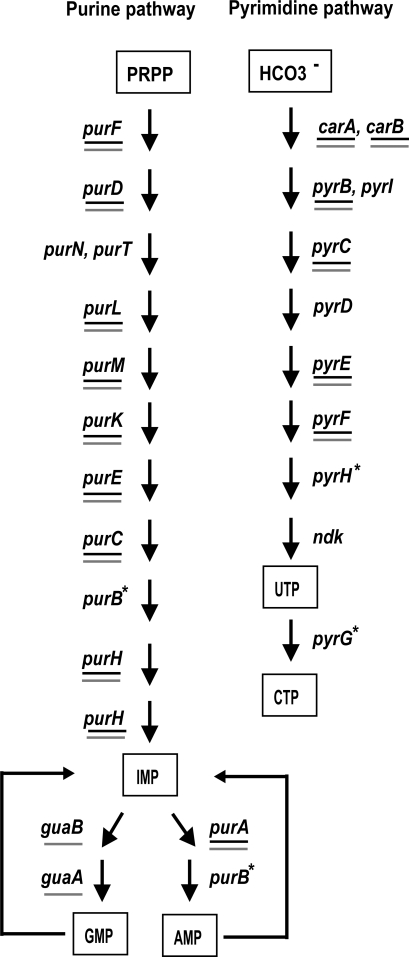
Genes Required for the Growth of E. coli in Human Serum Identified by MGK and MTT AssayPurine and pyrimidine nucleotide biosynthesis pathways in E. coli are outlined. Genes that were identified to be essential for the growth of E. coli in human serum by the MGK approach are underlined in black and those identified by the MTT assay are underlined in grey. Essential genes, whose deletions are absent from the defined library of E. coli mutants, are marked by an asterisk. Genes whose deletion does not confer a growth defect in serum are pyrI, ndk, purN and purT. The pyrD mutant was not identified by either screen, although it showed a growth defect in human serum.